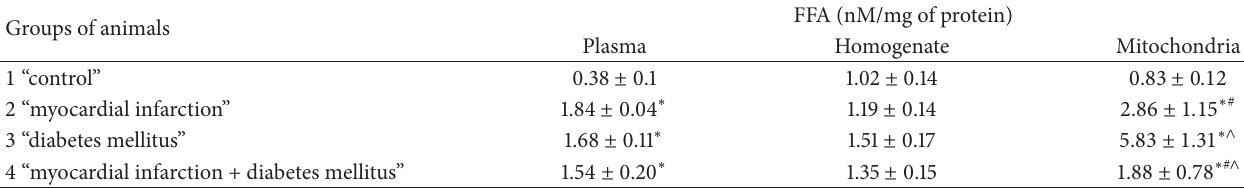
Table 1: Fatty acid content in blood plasma, myocardial homogenate, and cardiac mitochondria from experimental rats ( 𝑋 ± 𝑚 ). Groups of animals